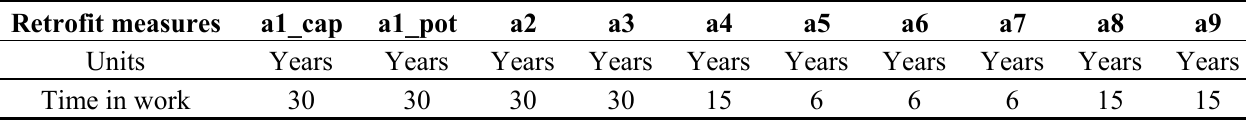
Table 6. Service life of each measure.